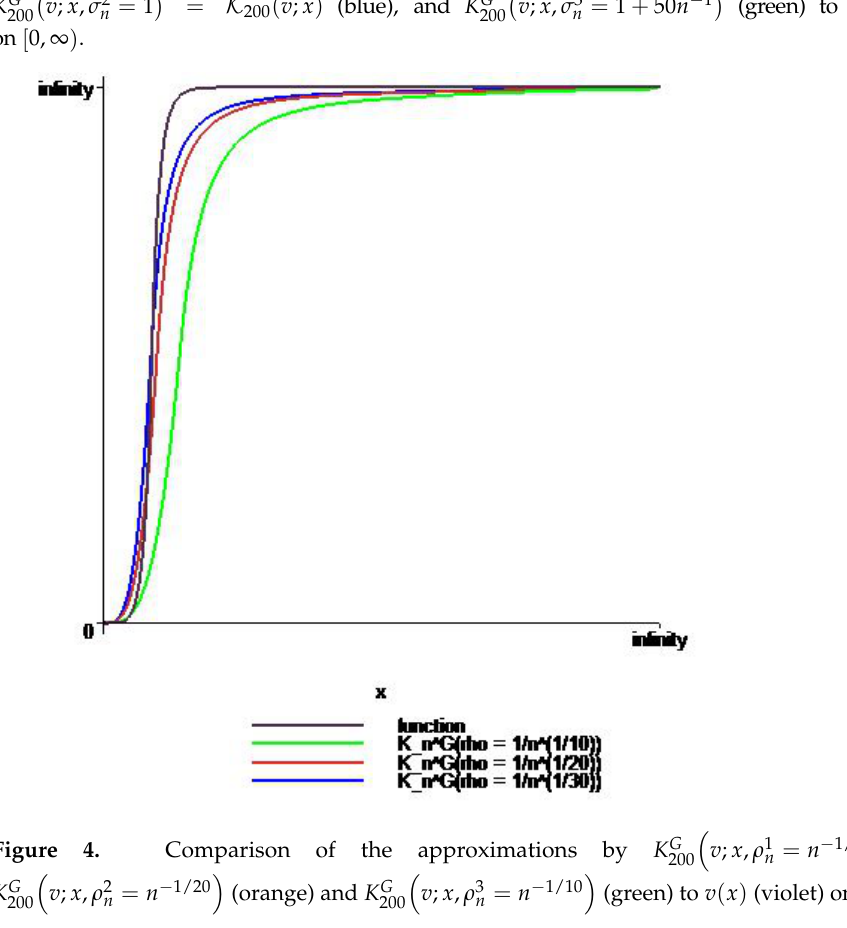
(cid:16) v ; x , ρ 3 n = n − 1/10 200